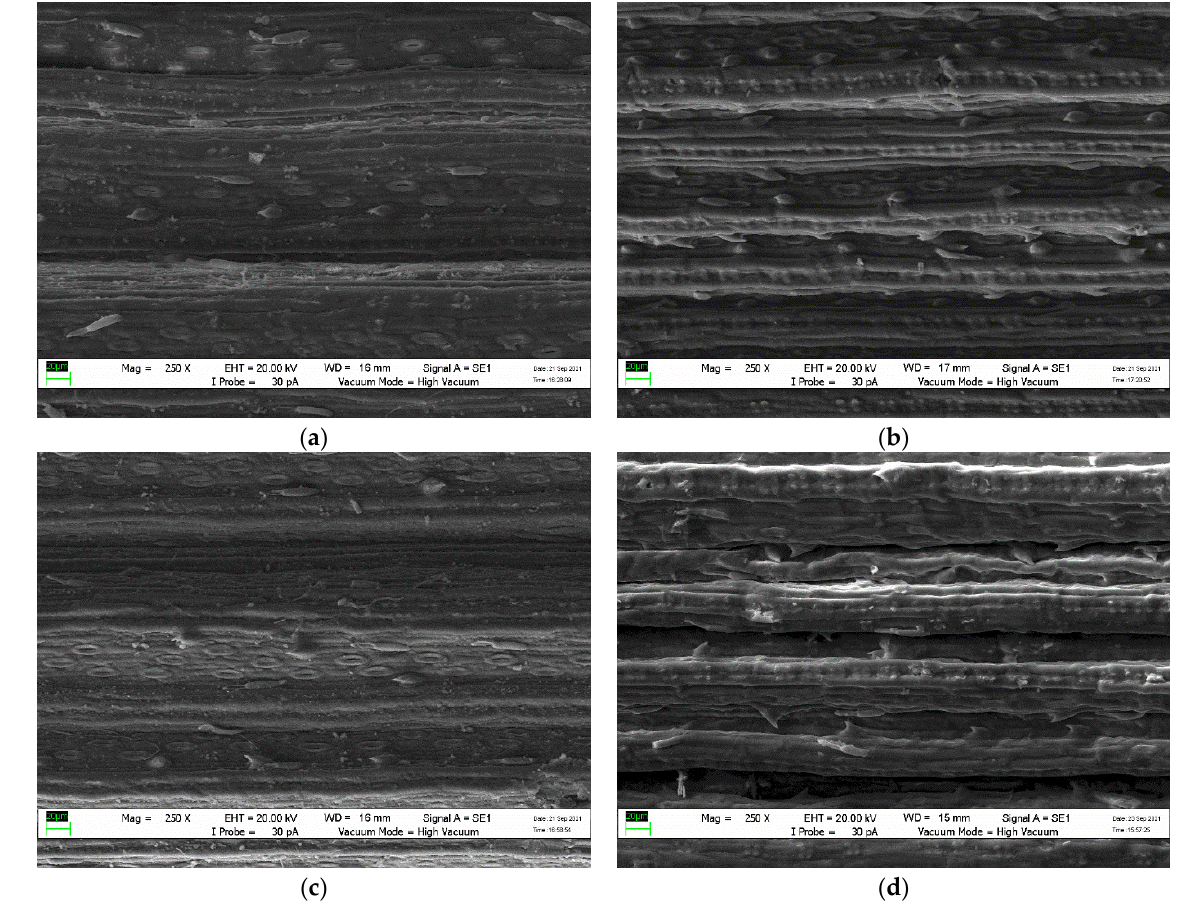
Figure 5. Scanning electron microscopy (SEM) micrograph of ( a ) untreated cogon grass before sorption; ( b ) treated cogon grass before sorption; ( c ) untreated cogon grass after sorption; and ( d ) treated cogon grass after sorption at magnifications 250×. Treated cogon grass was heated at 120 °C for 45 min.